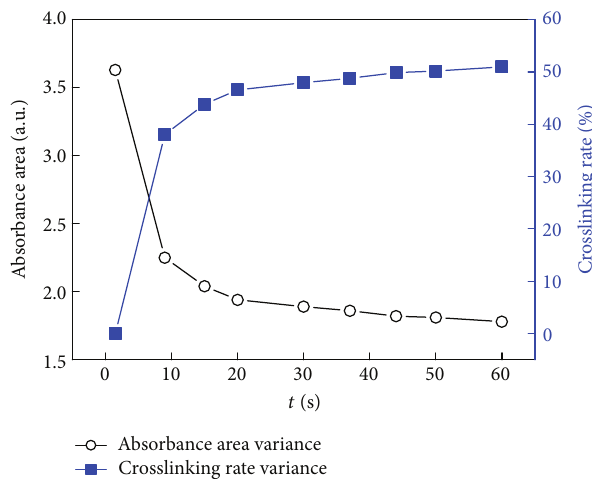
Figure 7: The C=C absorbance area and the calculated crosslinking rate in microcapsule under